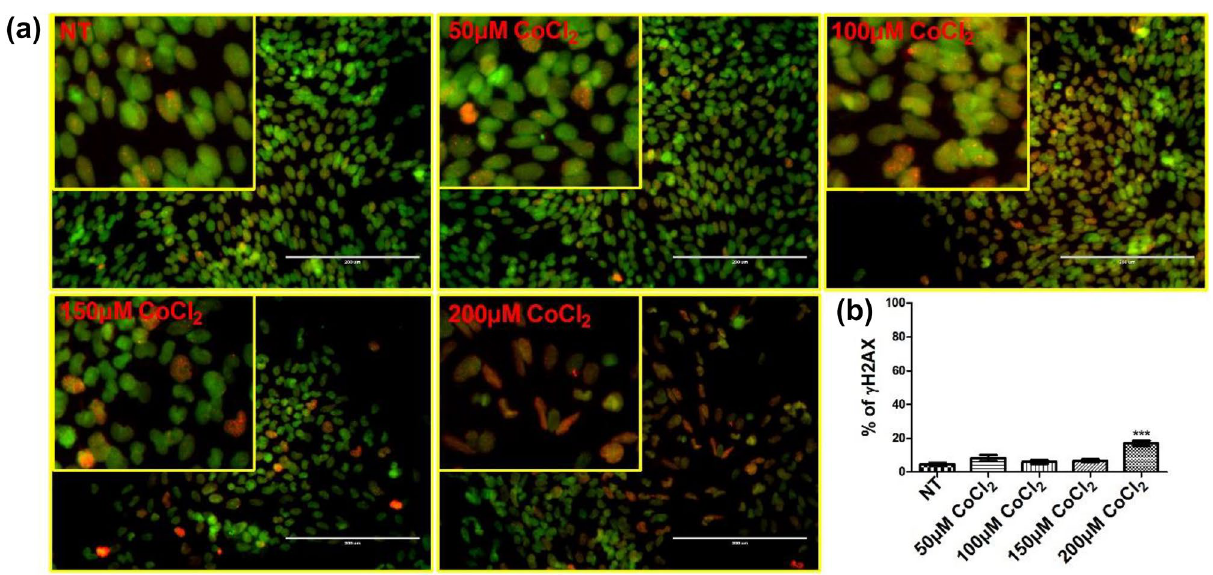
Figure 3. Gamma ‐ H2AX immunofluorescence staining. Primary ovarian cancer cells were incubated with various concentrations of CoCl 2 (50,100,150 and 200 µM) for 48 h. ( a ) Cells were stained with Hoechst 33342 (Green) and γ ‐ H2AX (red) and then five microscopic fields per well were scanned and analysed using the Cytell imaging system. ( b ) The number of γ ‐ H2AX stained cells were automatically counted and data presented as mean ± SEM (n = 3). Data was analysed using one ‐ way ANOVA with Tukey’s post-test analysis relative to corresponding not treated controls (NT), *** p <